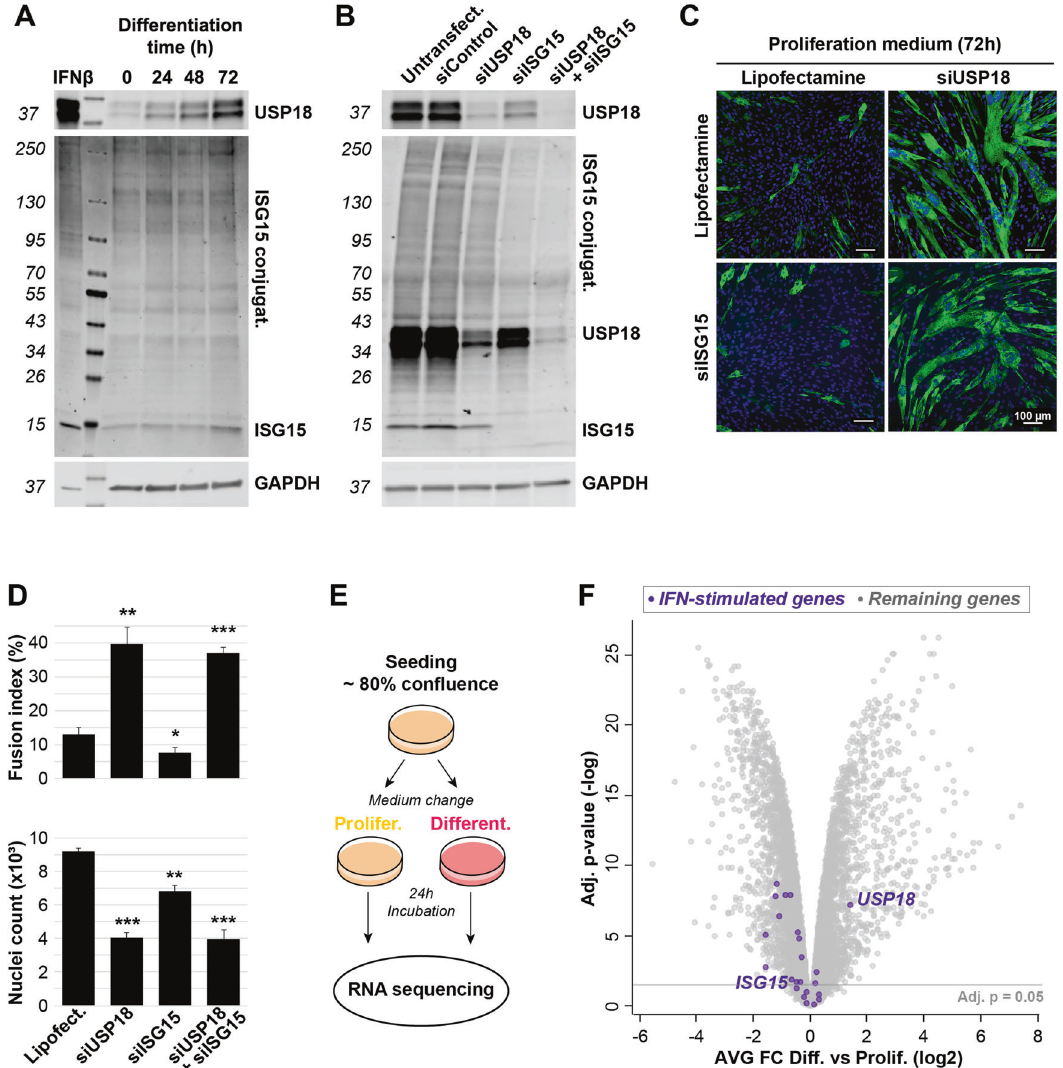
Fig. 4 Elevated USP18 expression during muscle cell differentiation is IFN-1-independent. A Western blot against USP18 and ISG15 during immortalized muscle cell differentiation. GAPDH is used as loading control and IFN β treatment was used as positive control. B Western blots show USP18, ISG15 and ISG15 conjugates in untransfected, siControl, siUSP18, siISG15 or siUSP18 + siISG15 double transfected immortalized cell cultures treated with IFN β treatment (1000 U/mL) for 24 h in proliferating medium. GAPDH was used as loading control. C Representative immuno fl uorescence images show MyHC staining in siUSP18, siISG15 or siUSP18 + siISG15 immortalized cell cultures incubated in proliferation medium for 72 h. Nuclei are counter-stained with DAPI (blue). Scale bar is 100 μ m. D Bar charts show fusion index for the respective cell cultures. Average and error bars (SD) are from N = 3. Statistical signi fi cance is depicted with asterisks. (*0.05 – 0.005, **0.005 – 0.0005, ***< 0.0005). E RNA sequencing experimental setup. Differentiation was induced by medium starvation without the presence of horse serum. F Volcano plot of transcriptome ( N = 3) shows mRNA fold change vs. p value between proliferation and differentiating immortalized muscle cell cultures. The interferon type-1 induced genes are highlighted in purple. The adjusted p value of 0.05 is depicted. If USP18 would affect protein levels, we would expect major (Supplementary Fig. S6A). Protein fold-change of MYOG agreed with changes in the USP18-dependent proteome in differentiated the transcript fold change (Supplementary Fig. S6B). Together, this cell cultures. Protein abundance was determined in differen- suggests that differentiation in USP18 KD cells is in part via the tiated cell cultures using label-free liquid chromatography canonical myogenic differentiation program, and expression level of tandem mass spectrometry (LC-MS/MS). Using a high statistical these myogenic factors is affected by USP18. con fi dence threshold (FDR 0.05), only six proteins were The transcriptome-wide changes caused by USP18 depletion led affected by USP18 KD. Considering an FDR of 0.25, altered us to hypothesize that USP18 may be present in the nucleus during levels of 63 proteins were signi fi cant (Fig. 7A). In total, only cell differentiation. A western blot analysis of subcellular fractions 0.18% or 1.88% of the proteins were affected by USP18 in revealed the accumulation of the USP18 34 kDa isoform in the differentiated cells, respectively. This is a minor effect as nuclear fraction, whereas the 36 kDa isoform was only found in the compared to the USP18-dependent transcriptome. We con- cytosol of differentiated cells (Fig. 6D). Immuno fl uorescence staining fi rmed differentiation dependent elevation of the skeletal in multinucleated myo fi bers con fi rmed this observation (Fig. 6E). In muscle markers MyHC, TNNI1, TNNT3 and KLH31L at the agreement, a truncated isoform of USP18 that retains catalytic protein level (Fig. 7B). activity has been found to be expressed in the nucleus [37]. Cell Death and Disease (2023)